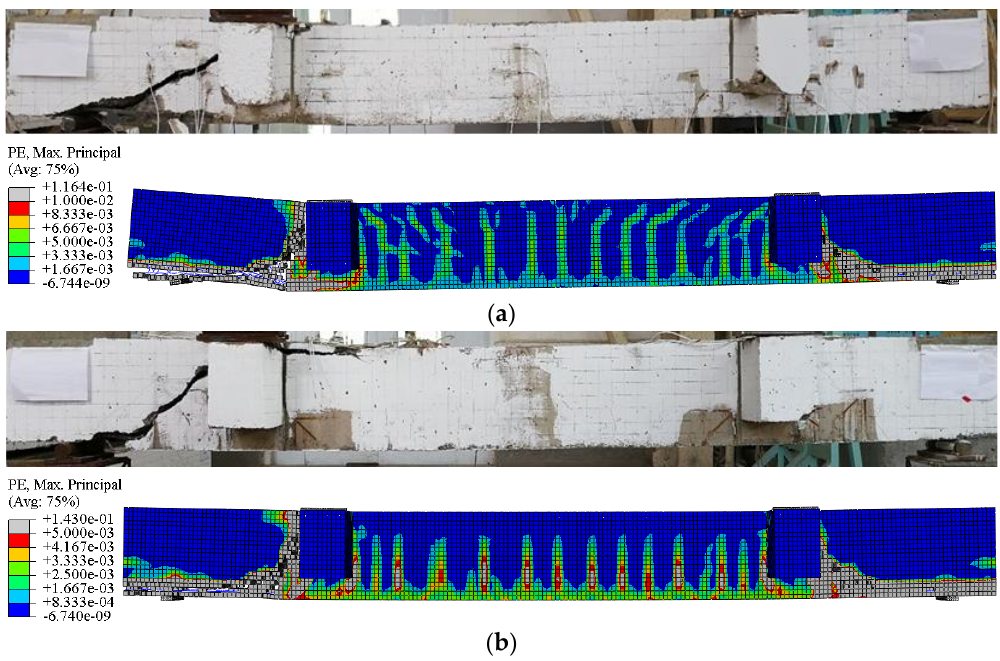
Figure 15. Failure mode predicted from the FE models: ( a ) JJLH1 and ( b ) JJLH2.